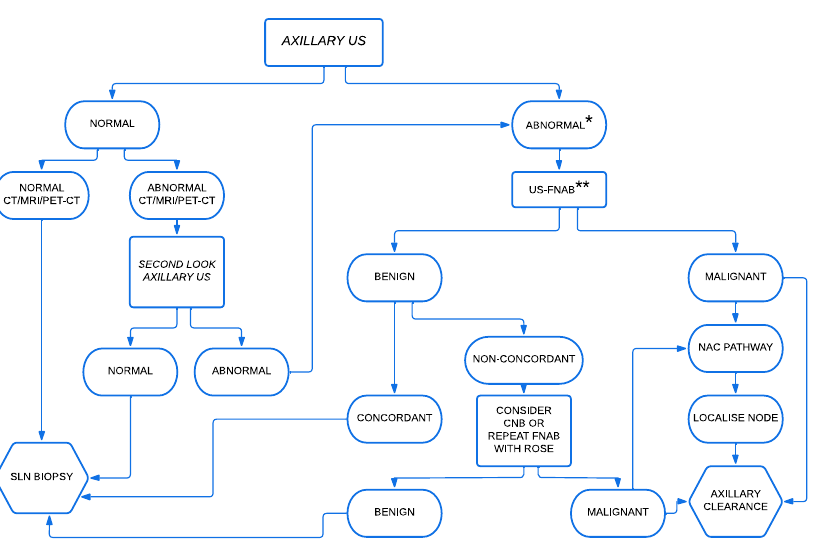
Figure 15. Axillary Nodal Staging Flowchart. US- Ultrasound, SLN—Sentinel lymph node, NAC— Neoadjuvant chemotherapy. * Suspicious features: Absent hilum, round nodal shape, cortical thickness of >4mm, irregular cortical outline. ** If smear suboptimal, repeat FNAB with ROSE.